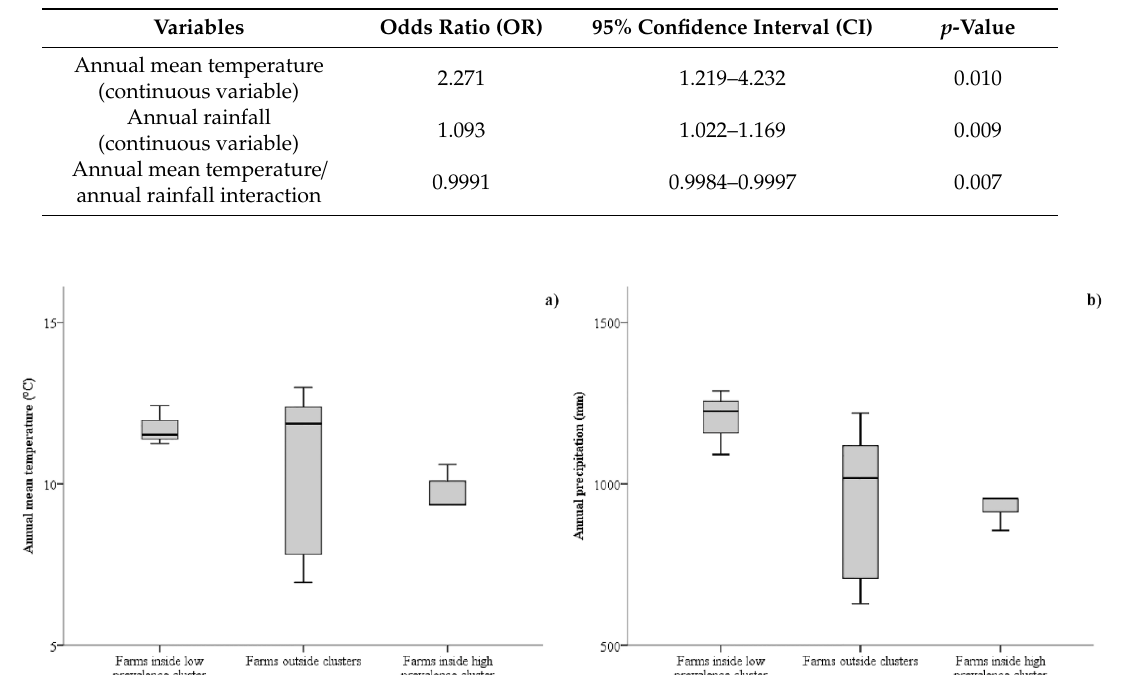
Table 3. Possible risk factors associated with higher Neospora caninum prevalence in sheep farms using univariate